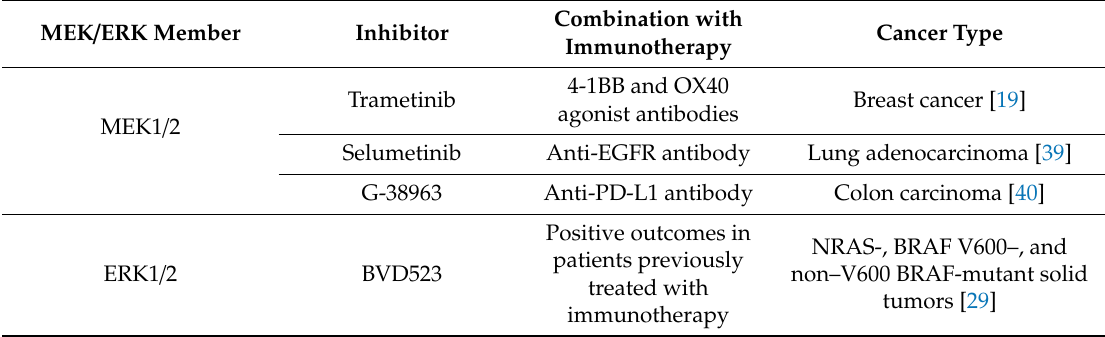
Table 1. MEK / ERK inhibitors and immunotherapy in